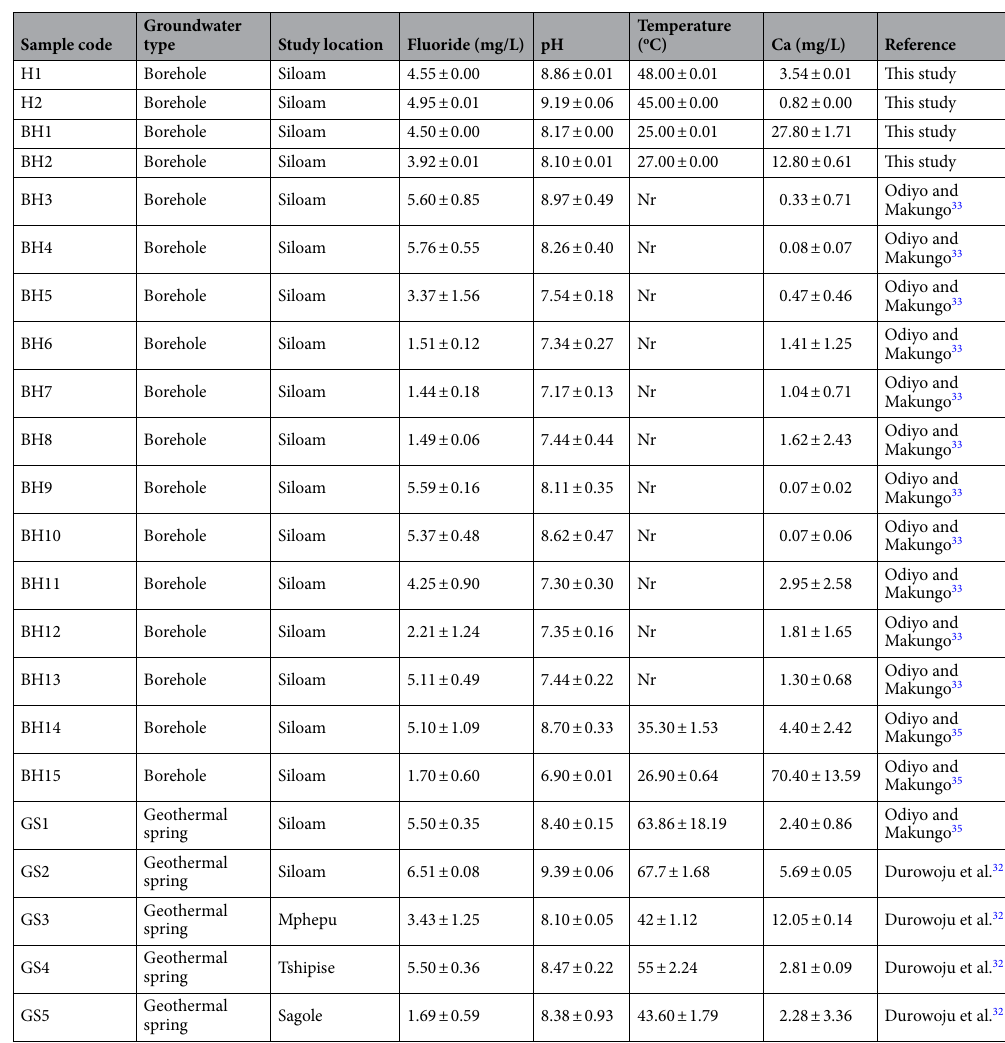
Table 2. Mean fluoride, pH, temperature and calcium levels of groundwater in the study area. Nr not